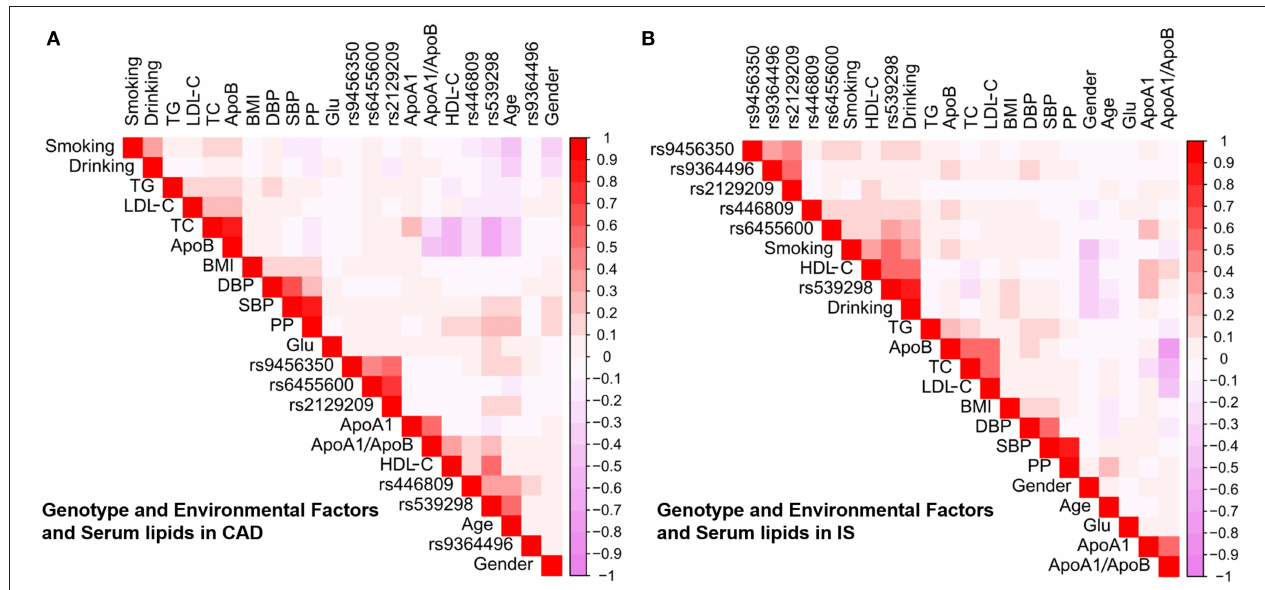
FIGURE 6 | Association between environmental exposures as well as the candidate loci and serum lipid parameters in CAD (A) or IS (B) . CAD, coronary artery disease; IS, ischaemic stroke. SBP, systolic blood pressure; TC, total cholesterol; BMI, body mass index; TG, triglyceride; ApoA1/B, the ratio of apolipoprotein A1 to apolipoprotein B; HDL-C, high-density lipoprotein cholesterol; DBP, diastolic blood pressure; LDL-C, low-density lipoprotein cholesterol; ApoA1, apolipoprotein A1; PP, pulse pressure; ApoB, apolipoprotein B; Glu,